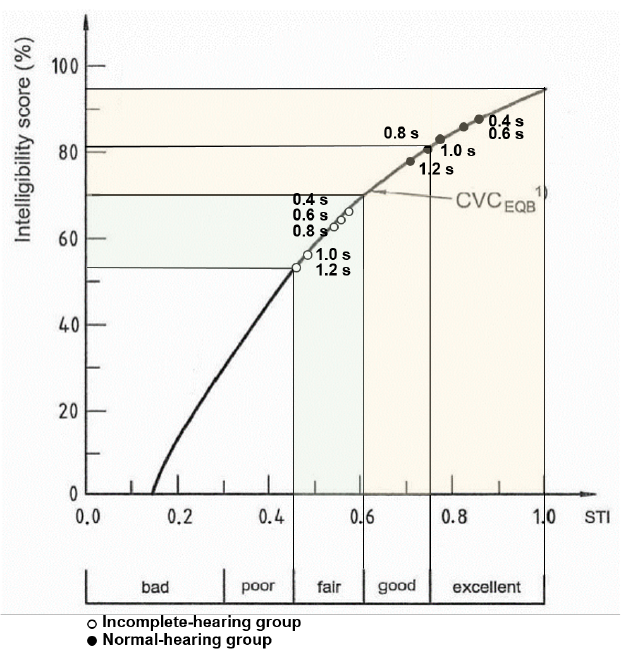
Figure 13. Relationship between the speech intelligibility test results of the two groups and STI standard.